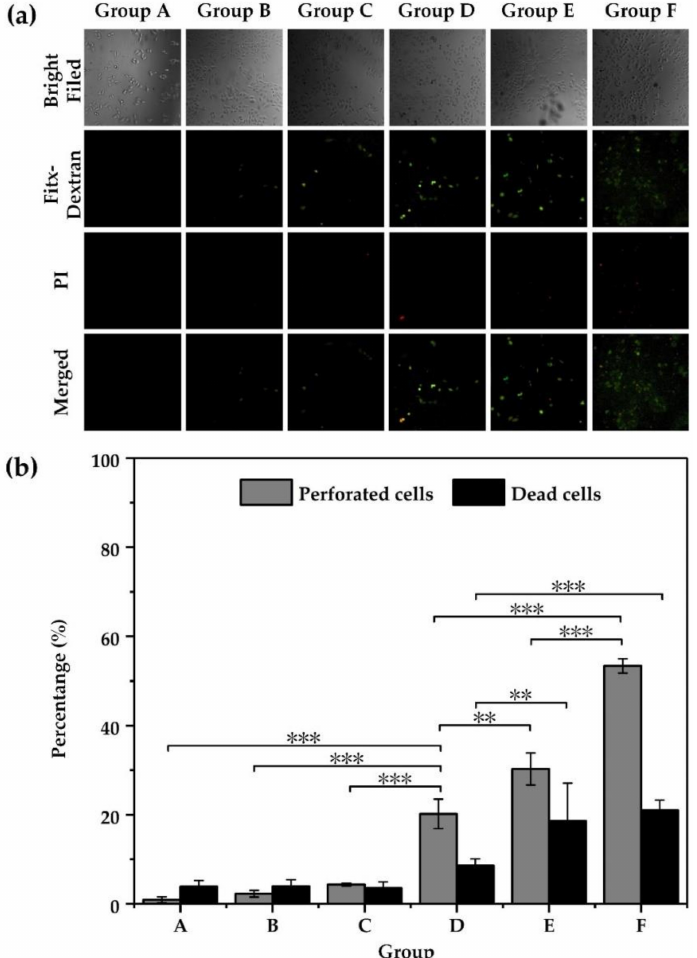
Figure 7. Delivery of Fitc-dextran (10 kDa) into HeLa cells by EGFR antibody functionalized AuNPs’ mediated photoporation. ( a ) Fluorescence images of the intracellular delivery of FD10 for HeLa cells after treatment with laser-irradiated antibody-modified AuNPs. ( b ) The percentage of perforated and dead cells determined by flow cytometry for HeLa cells. Statistically significant differences are indicated by ** ( p < 0.01) and *** ( p < 0.001). Group A (with naked AuNPs): laser fluence: 0 J/cm 2